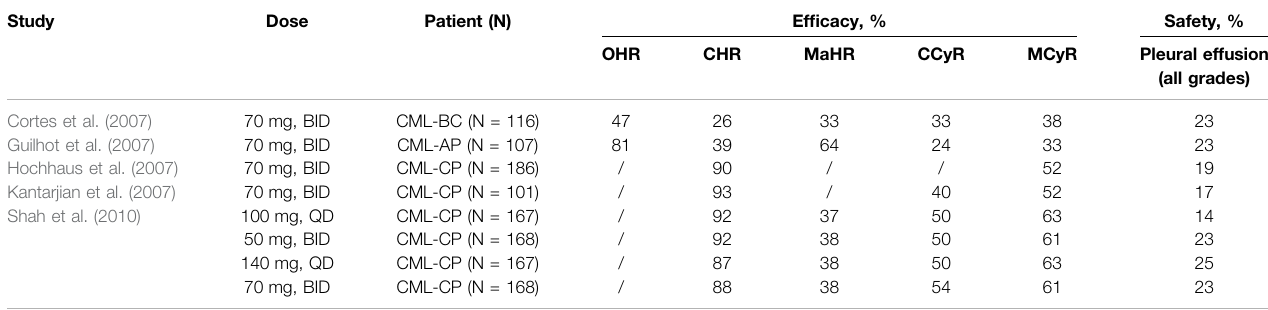
TABLE 2 | Overview of outcomes for patients administrated different oral dose of dasatinib. Study